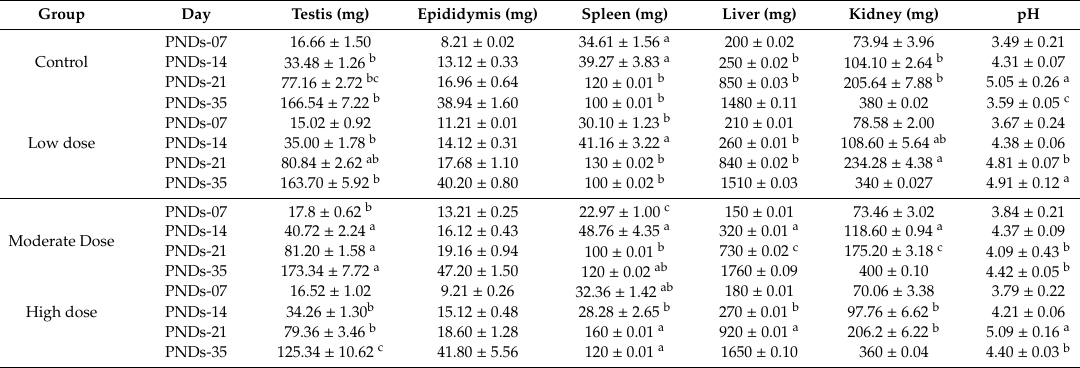
Table 2. Organs weight and pH measurement at di ff erent Post-Natal